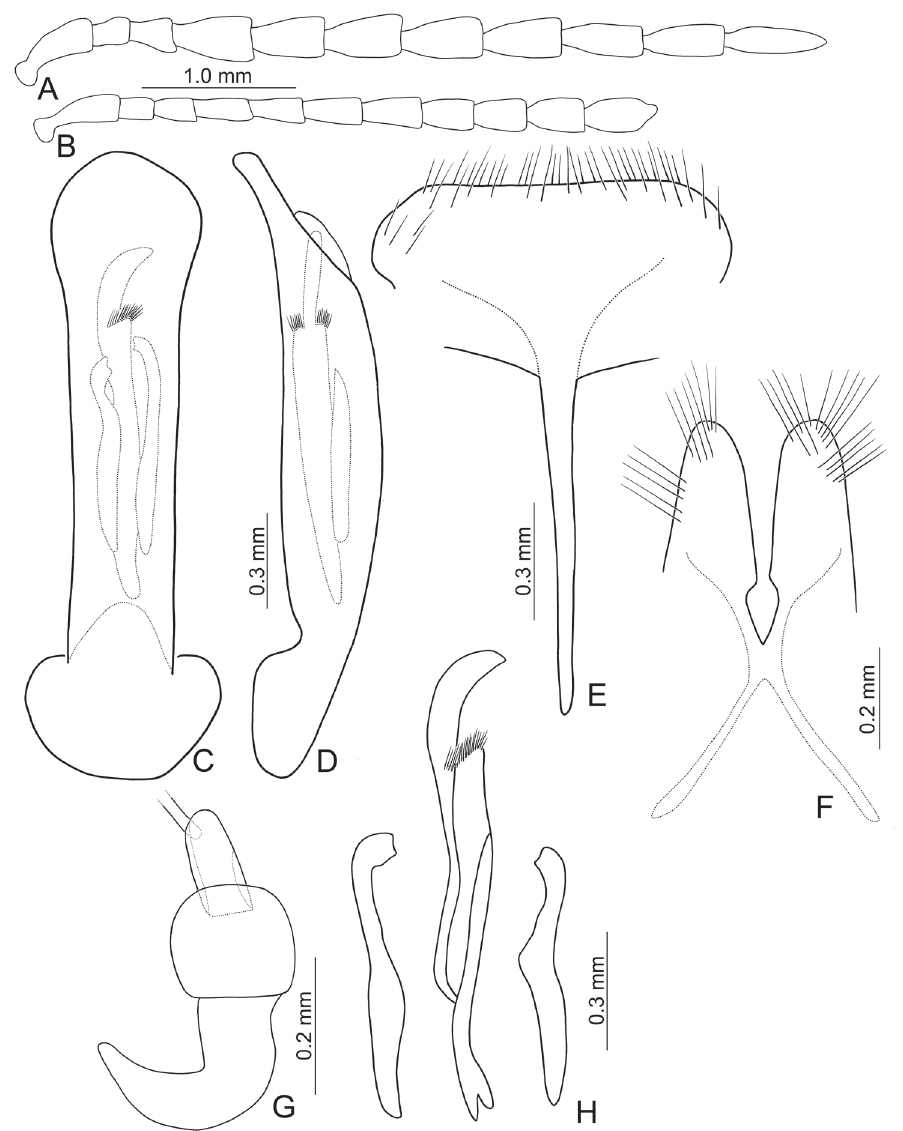
Figures 7. Diagnostic characters of Gallerucida lutea Gressitt & Kimoto. A Antenna, male B Antenna, female C Penis, dorsal view D Penis, lateral view E Abdominal ventrite VIII F Gonocoxae G Spermatheca H Endophallic